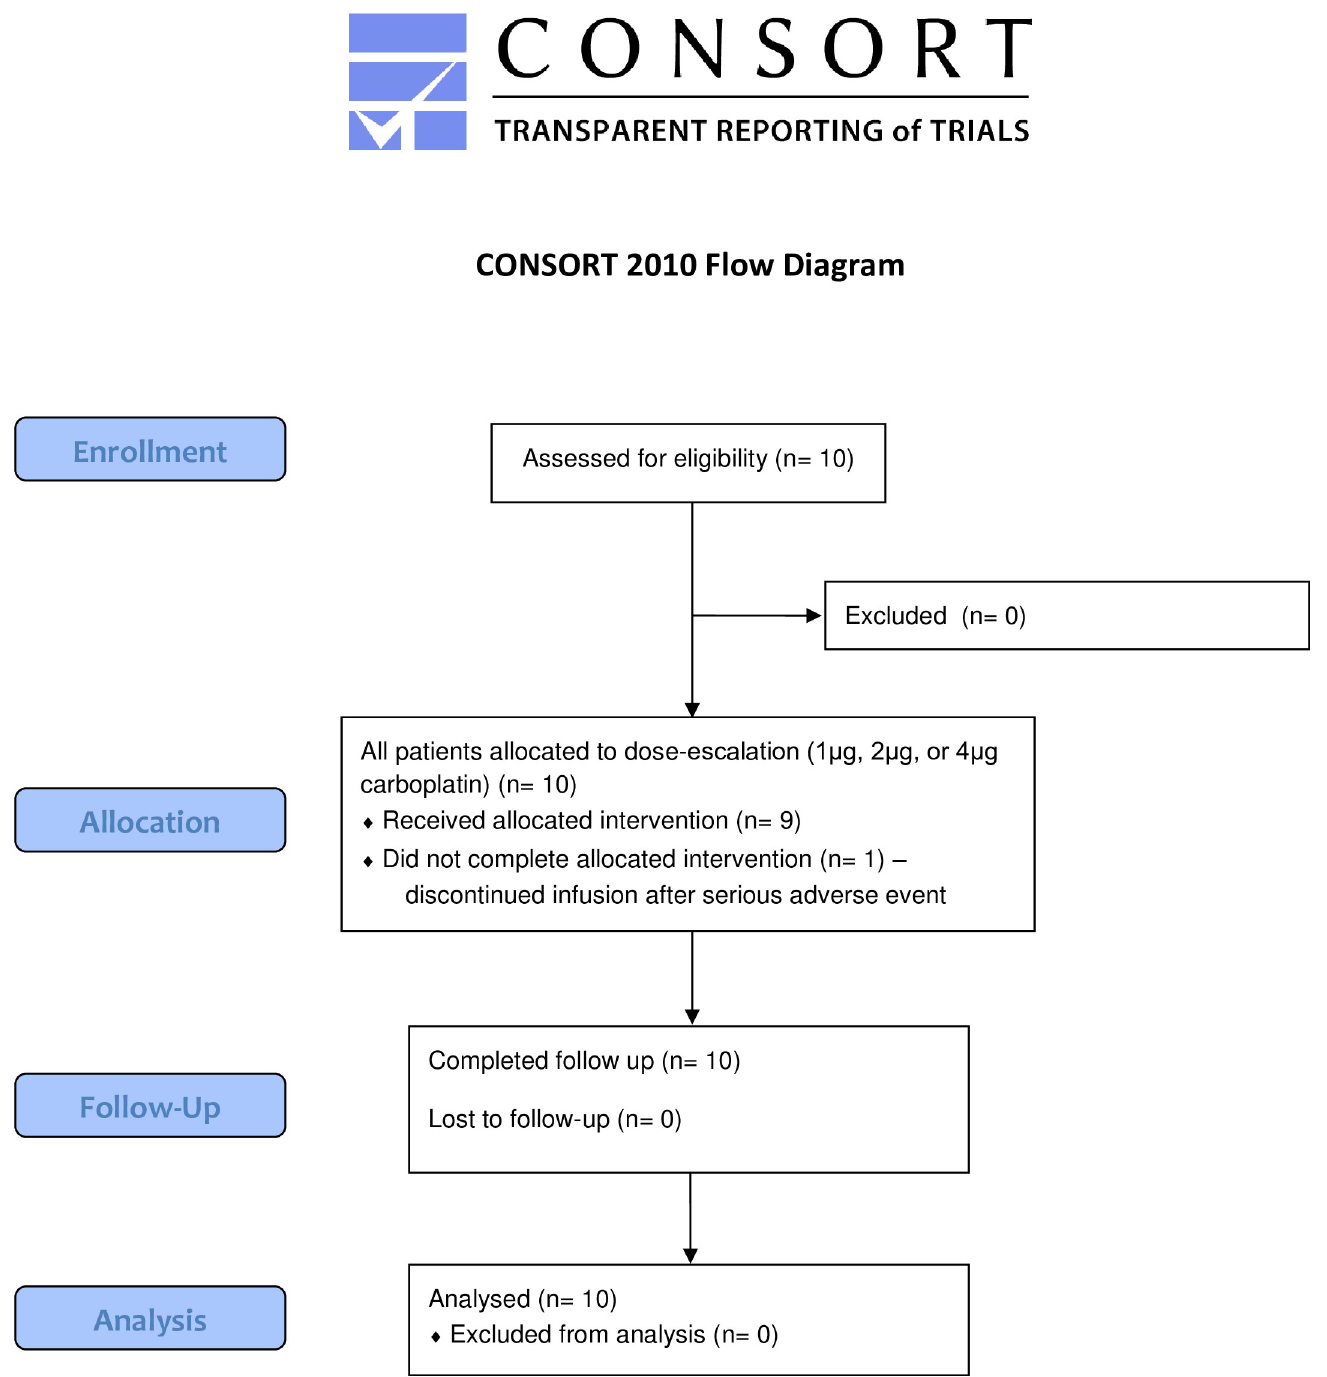
Fig 1. CONSORT flow